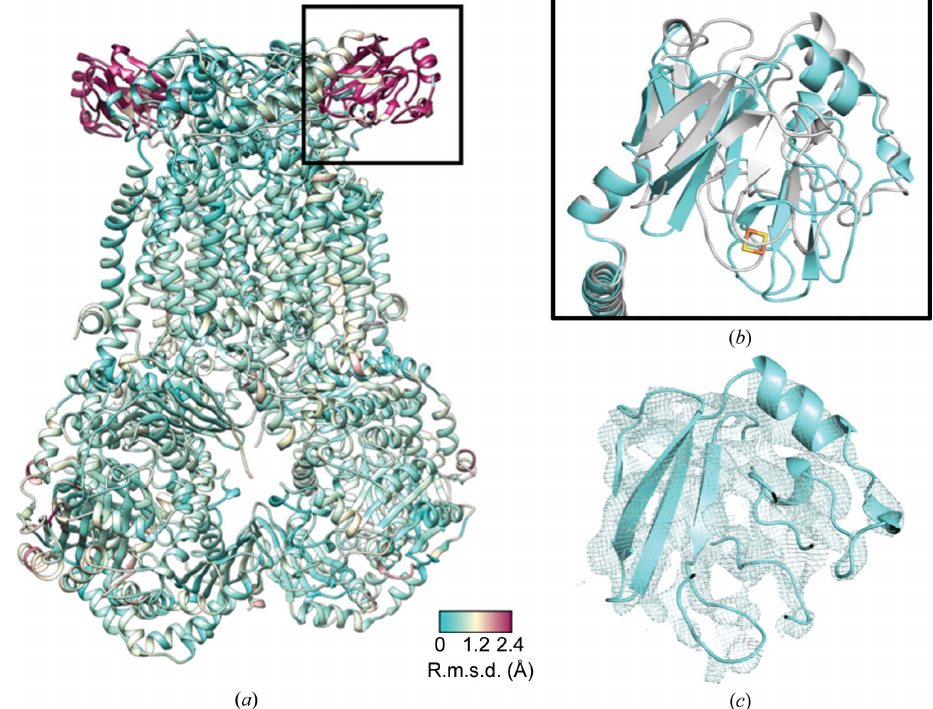
Figure 4 Global comparison between cryo-EM-derived and X-ray-derived SCR0911-bound structures. ( a ) The cryo-EM and X-ray bc 1 –SCR0911 structures have been overlaid and the crystal structure is coloured according to the calculated C (cid:4) r.m.s.d. value (low coloured cyan and high coloured maroon). The main difference (r.m.s.d. of >2 A˚ ) occurs for the Rieske domain (in the black square), which is known to be mobile during the catalytic cycle. ( b ) An overlay of the Rieske domains in the cryo-EM-derived (cyan) and X-ray-derived (grey) bc 1 –SCR0911 structures. ( c ) The cryo-EM-derived map for the bc 1 – SCR0911 structure with the Rieske domain fitted shown in the same orientation as in ( a ) and ( b